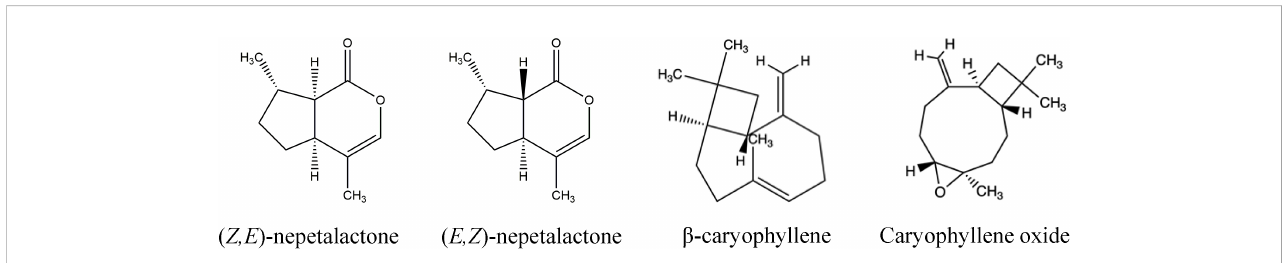
FIGURE 3 Chemical structures of Z,E -nepetalactone, E,Z- nepetalactone, b -caryophyllene and Caryophyllene oxide, the major components of the aromatic pro fi le of catnip cultivars CR9, CR3 and hybrid